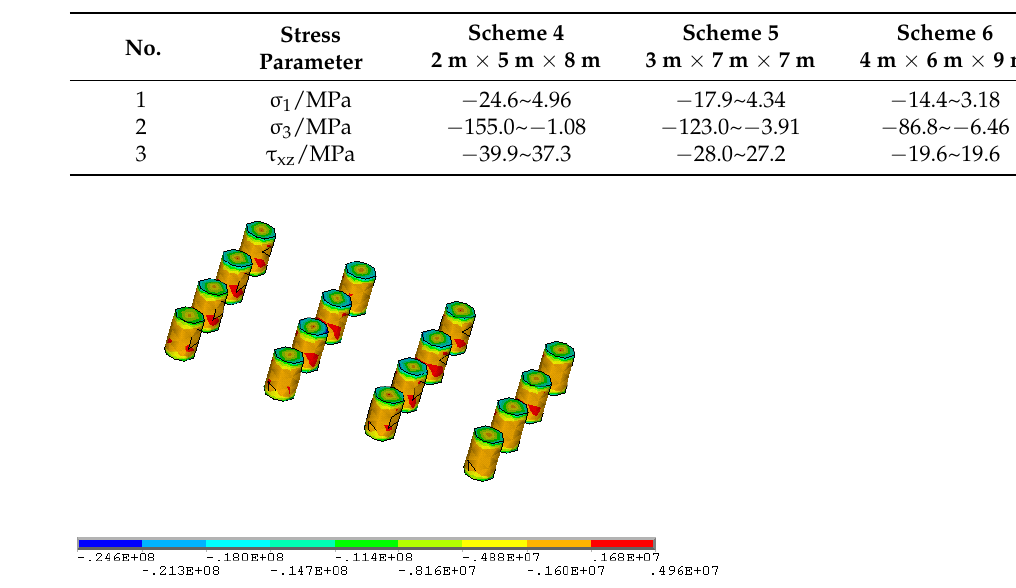
Figure 24. Maximum principal stress distribution in the middle of the pillar at 1480 mL of scheme 4 (parameters of scheme 4: stope height 3.5 m, pillar diameter 2 m, pillar spacing 5 m, pillar row spac- ing 8 m).